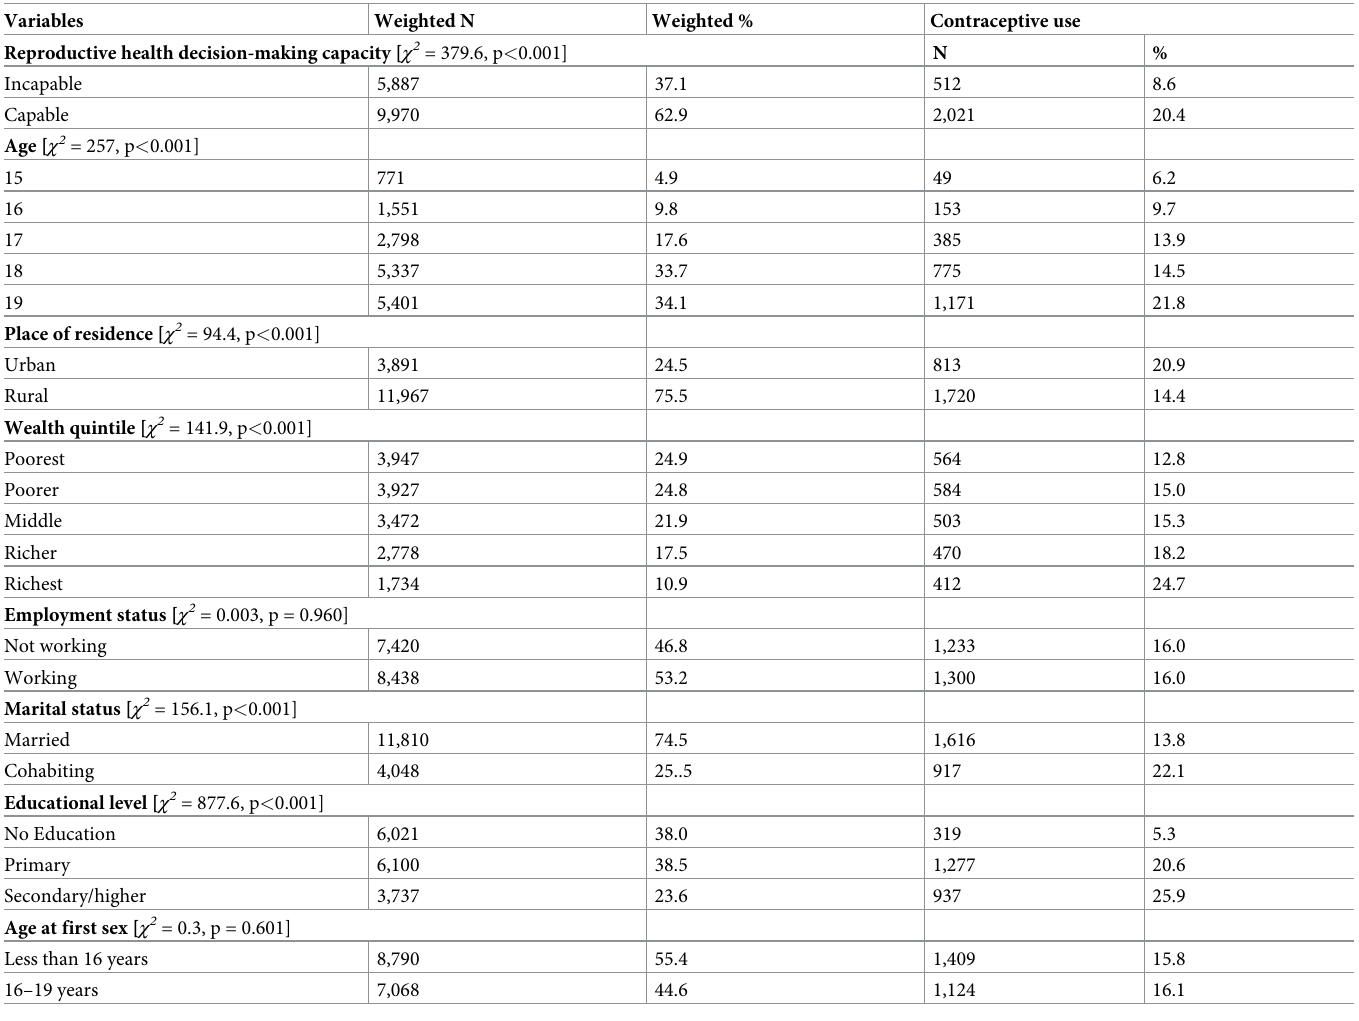
Table 2. Reproductive health decision-making capacity, socio-demographic characteristics, and contraceptive use among female adolescents in